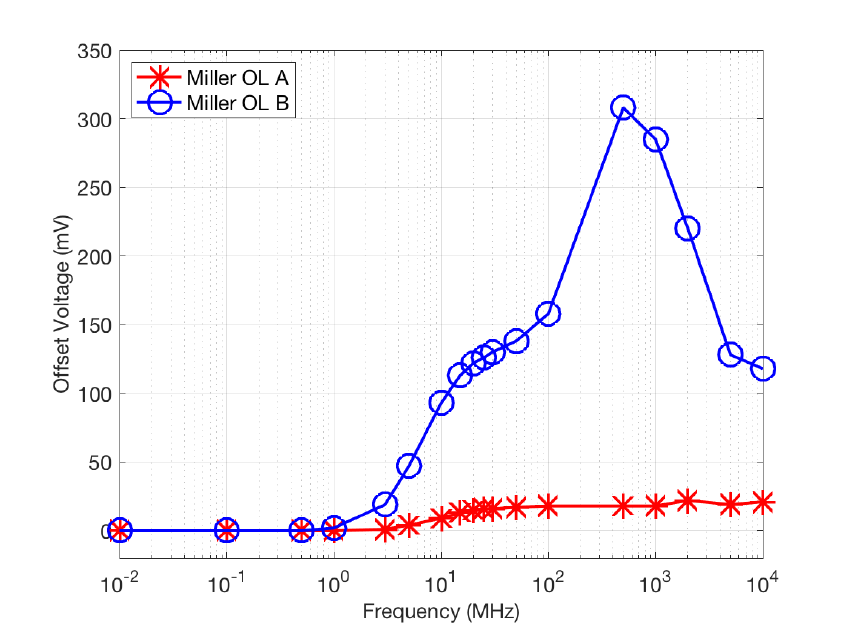
Figure 19. EMI induced offset in the Miller amplifier without RC network, open loop configuration.